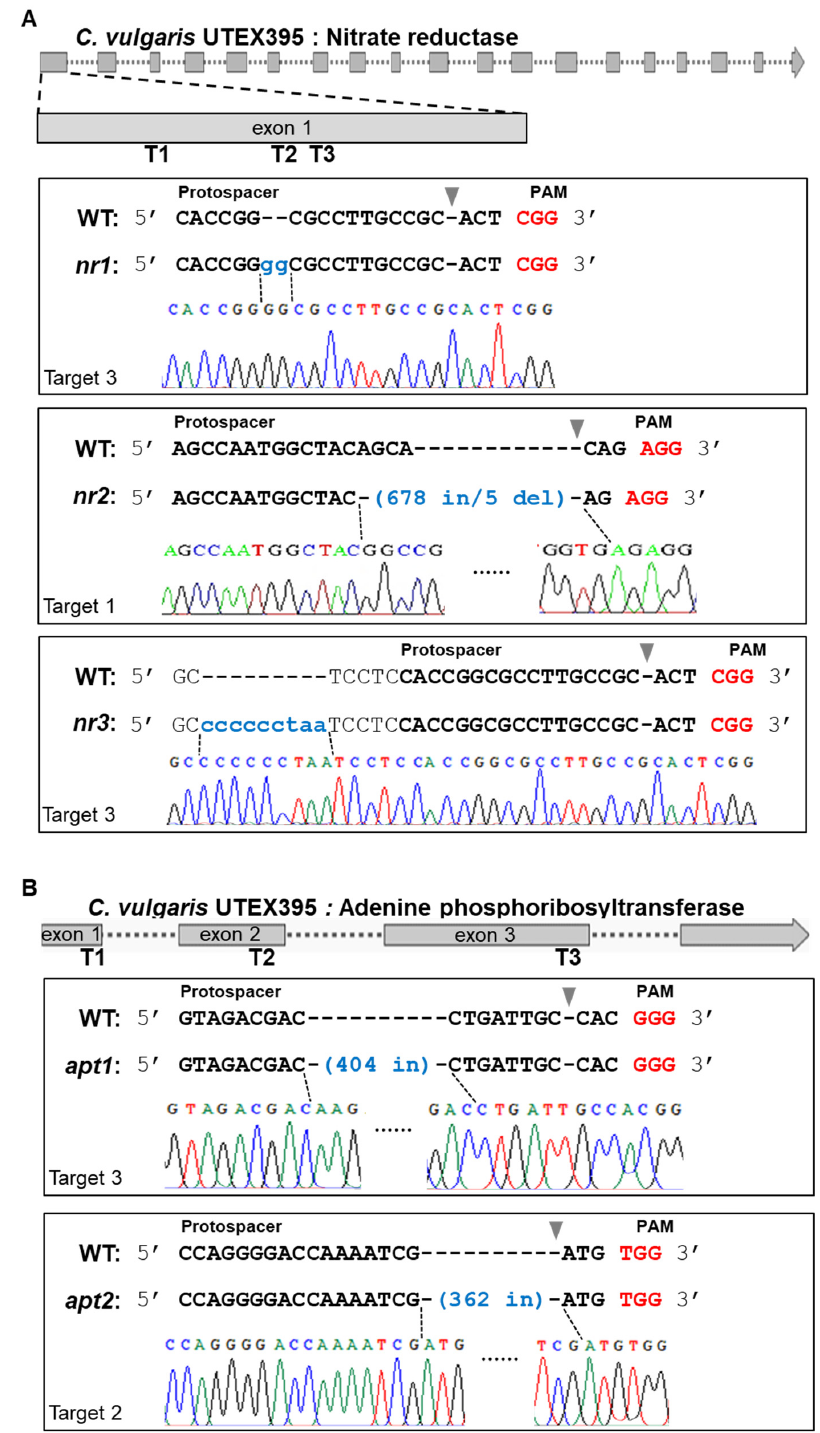
Figure 3. Sequence analysis of genome-edited mutants. ( A ) Edited genome sequences of nitrate reductase ( NR ) in nr mutants as determined by Sanger sequencing. The nr1 and nr3 mutants show a small insertion on target 3. The nr2 mutant displays a 678 bp insertion and a 5 bp deletion at target 1. ( B ) Edited genome sequences of adenine phosphoribosyltransferase ( APT ) in apt mutants as determined by Sanger sequencing. The apt1 mutant exhibits a 404 bp insertion at target 1, while apt2 shows a 362 bp insertion at target 2. Reverse triangles indicate the RuvC cleavage sites.